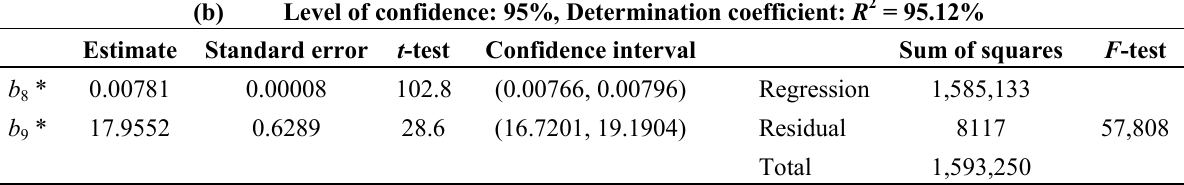
(b) Level of confidence: 95%, Determination coefficient: R 2 = 95.12%